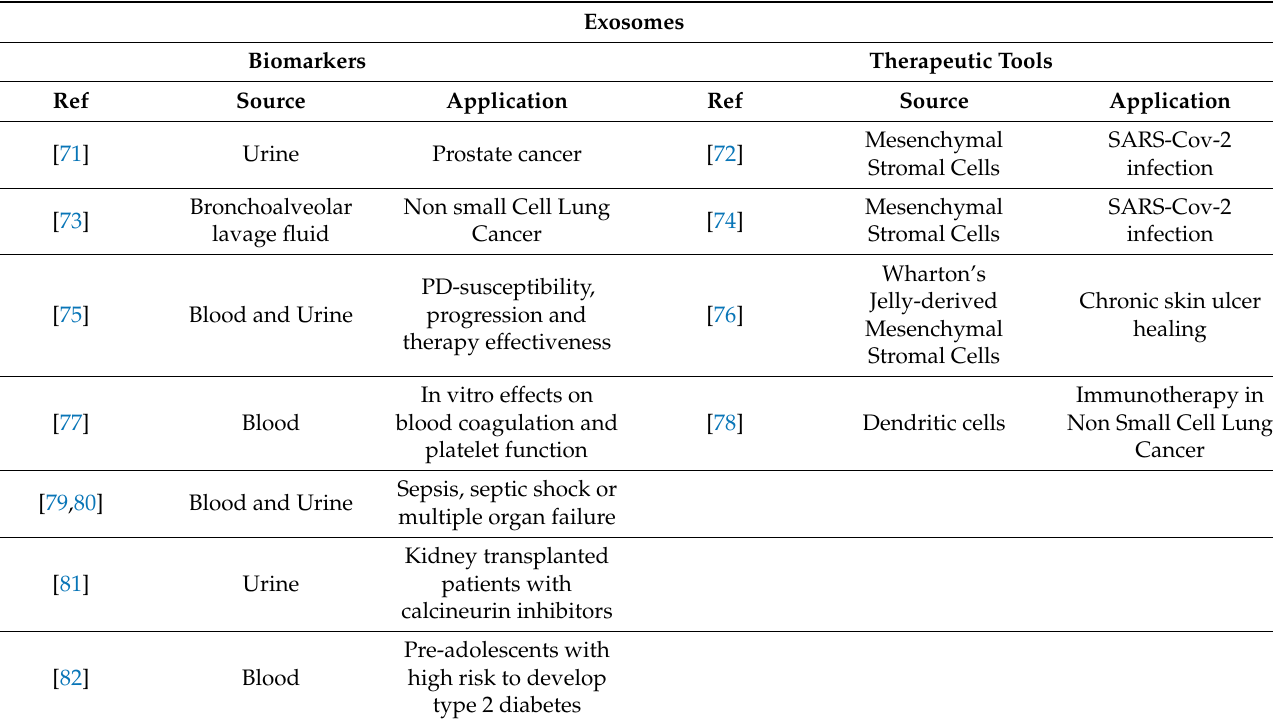
Table 2. Summary of clinical trials with “Exosomes” as biomarkers or therapeutic